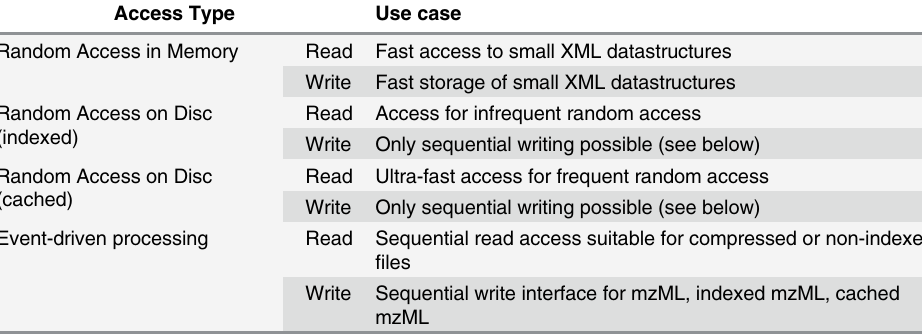
Table 1. Available access types of raw mass spectrometric data through OpenMS. This paper describes the implementation and use of the “ random access on disk ” (indexed mzML and cached mzML) and the “ event-driven ” access types and compares it to the previously available “ random access in memory ”